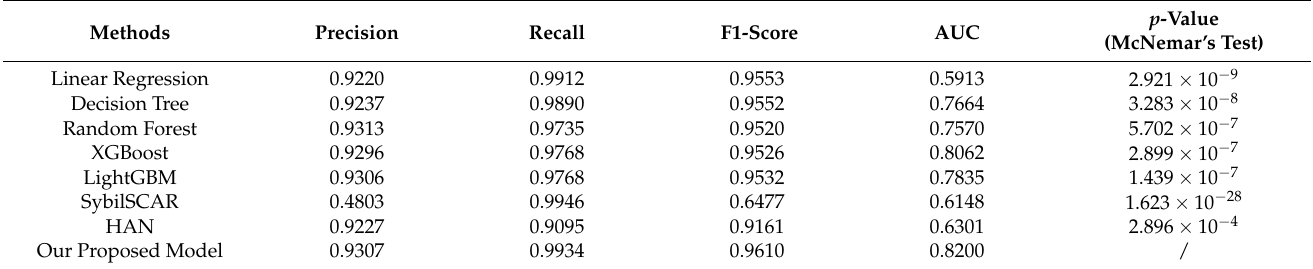
Table 2. Performance comparison with